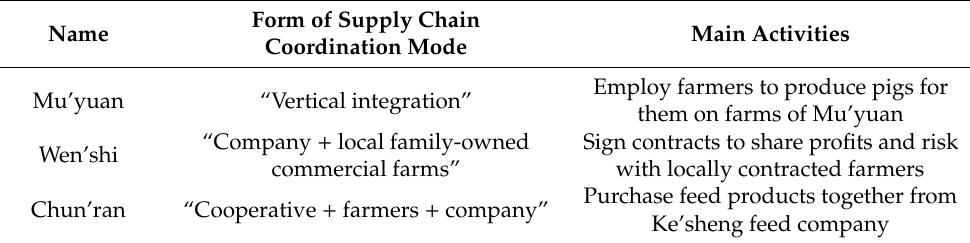
Table 2. Supply chain